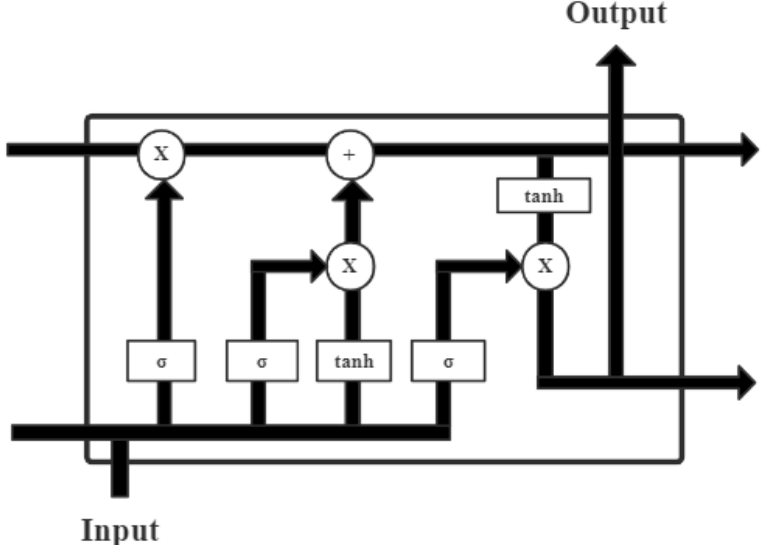
Figure 4. The architecture diagram of Long Short-Term Memory network model.